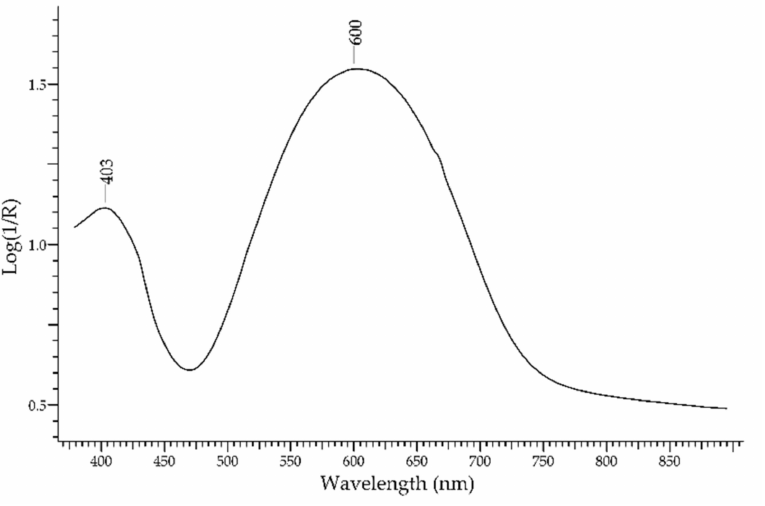
Figure 4. FORS spectrum in Log(1/R) coordinates of lapis lazuli.